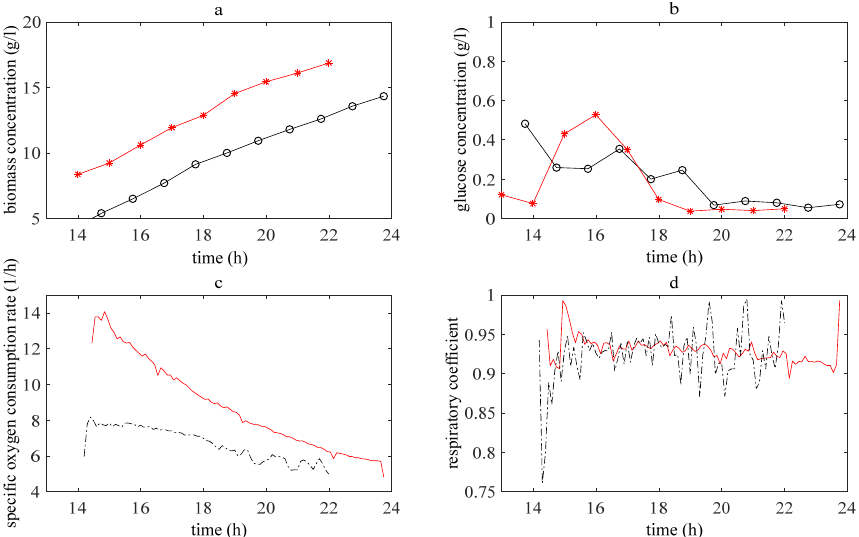
Figure 3. Inputs of software sensor: ( a ): biomass concentration, ( b ): glucose concentration, ( c ): specific oxygen consumption rate, ( d ): respiratory coefficient. Experiment I measurements (red lines); Experiment II measurements (black lines).